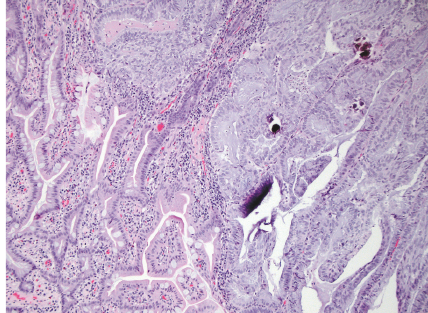
Figure 2: Hematoxylin and eosin staining shows fragments of large atypical cells with focal gland formation consistent with an adenocarcinoma.